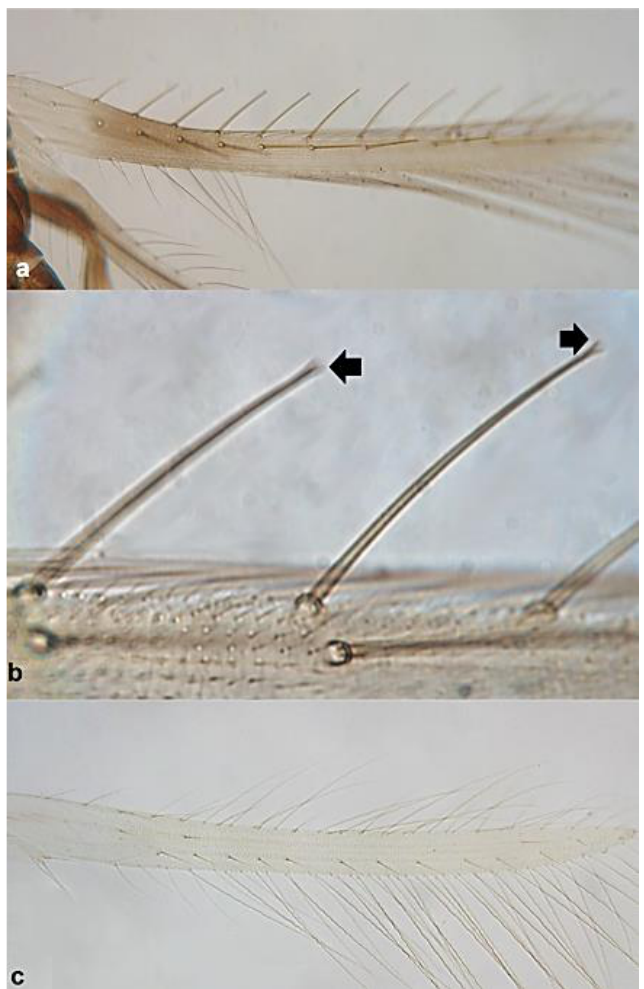
Figure 25. ( a ) Fore wing with second vein with no setae; ( b ) setae on vein of fore wing with capitate tips; ( c ) fore wing with second vein with setae. 27 Females micropterous; head with reticulate (network-like) sculpture; ridge present be- tween antennal sockets (Figure 26a) ........................... Prosopothrips nigriceps Bagnall Females macropterous; head with no distinct sculpture; ridge lacking between anten- nal sockets (Figure 26b) ........................................ Bregmatothrips dimorphus